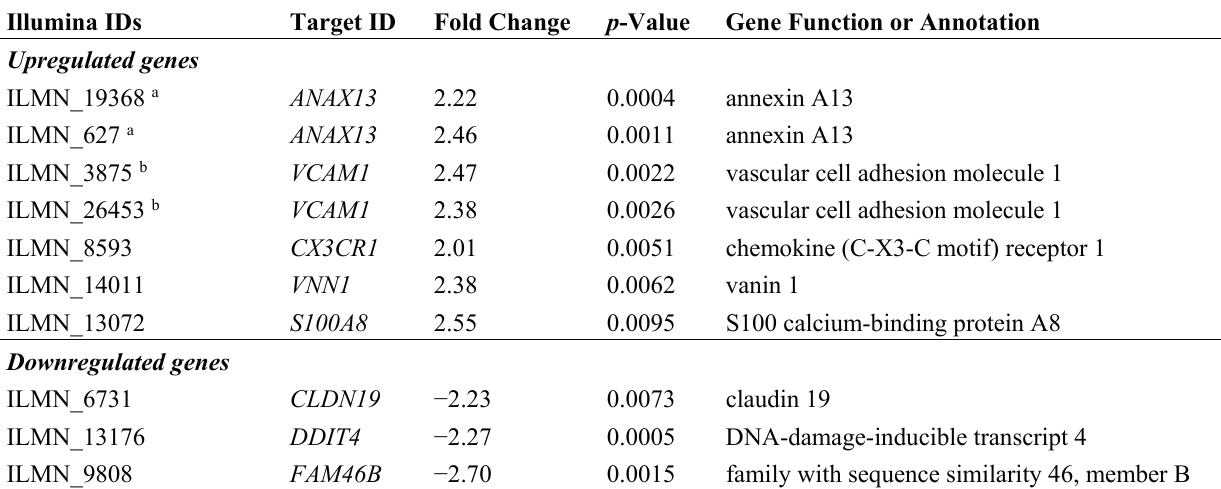
Table 3. List of candidate genes obtained from the therapeutic responders.